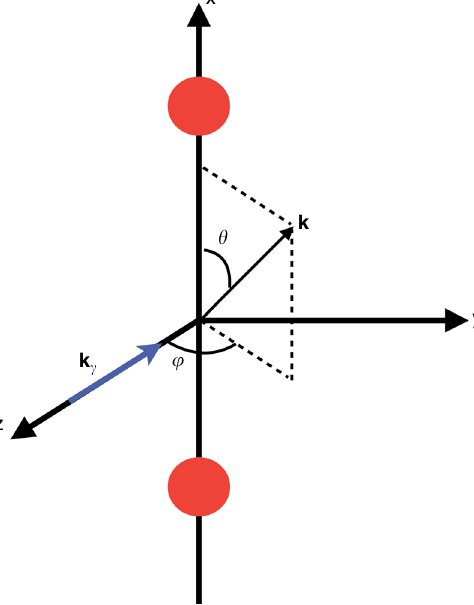
Fig. 5 Geometrical de fi nitions: polar angle θ and azimuthal angle φ de fi ning the direction of the electron momentum k with respect to the plane de fi ned by the internuclear axis ( x ) and the propagation direction k